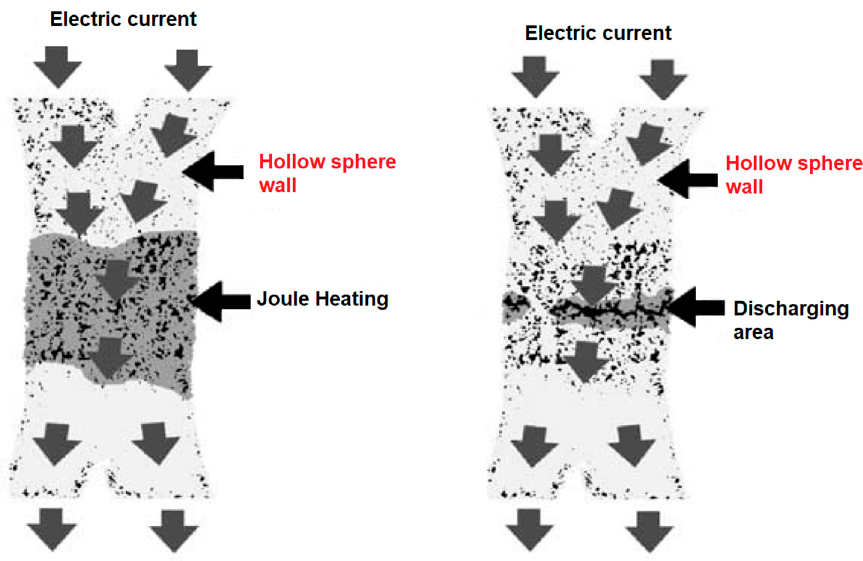
Figure 14. Densification of the wall of steel spheres by SPS. Reprinted from Khor et al. [55], Copyright (2003), with permission from Elsevier.